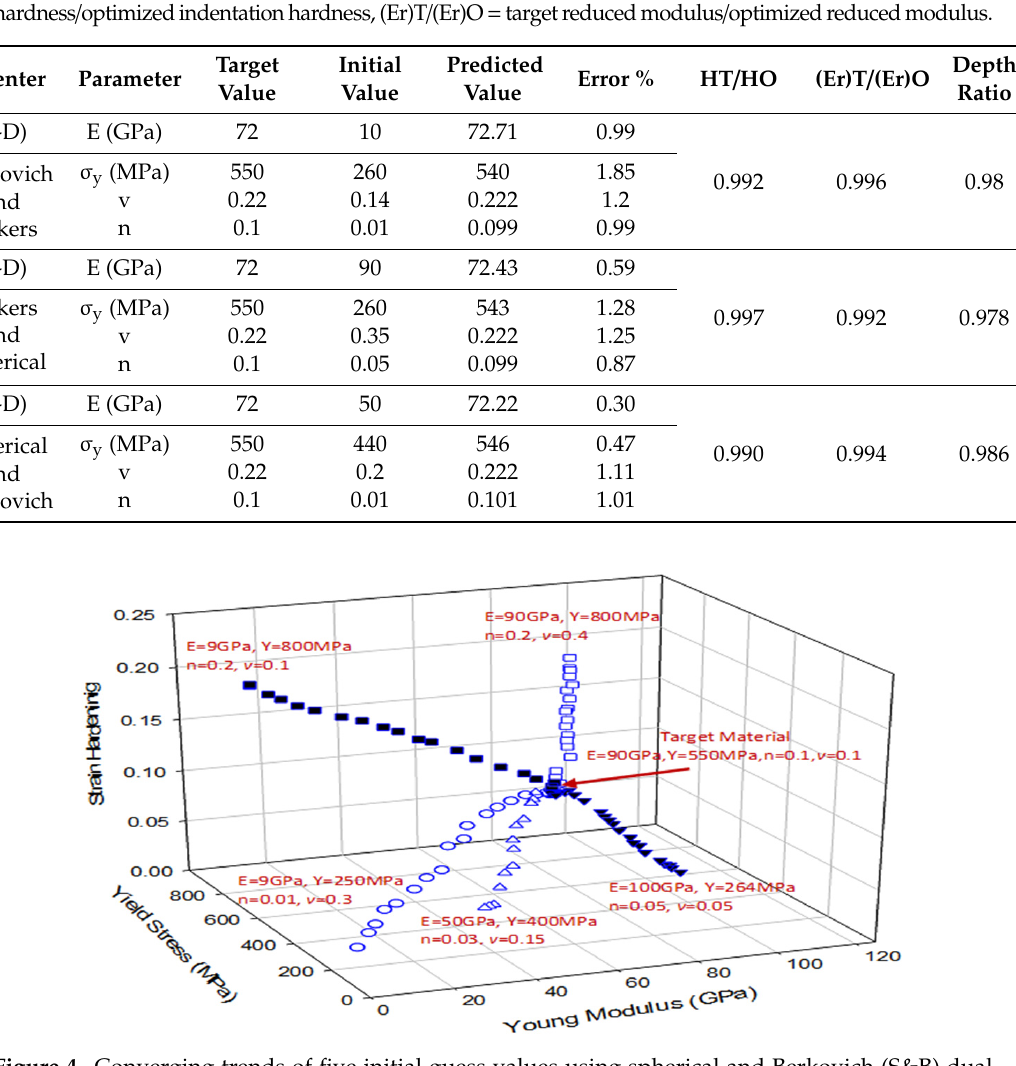
Table 1. Dual indenter optimization results of elastic plastic material. HT/HO = target indentation